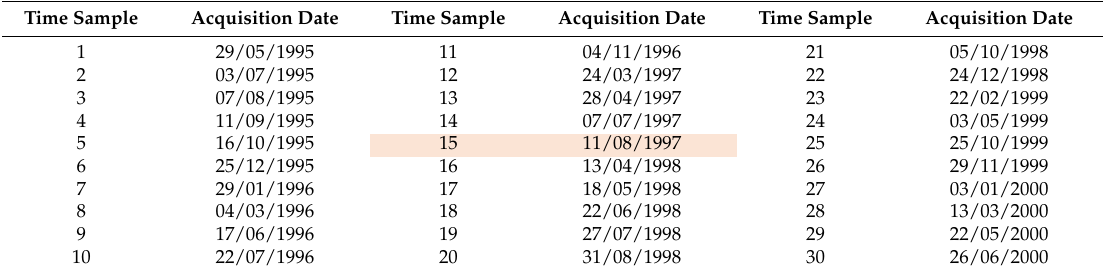
Table 1. The acquisition dates for the ERS image time series. Master acquisition highlighted